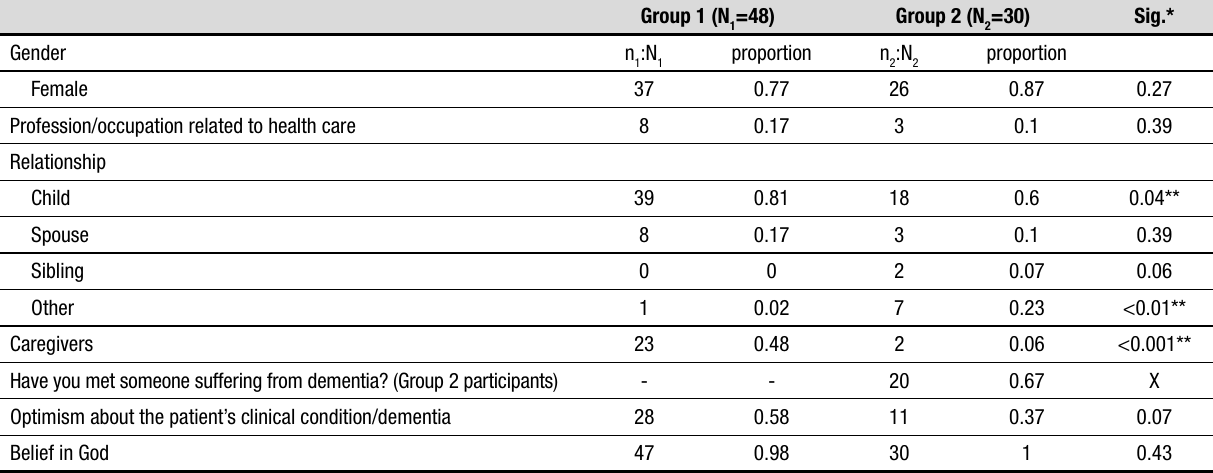
Table 1. Demographic characteristics of